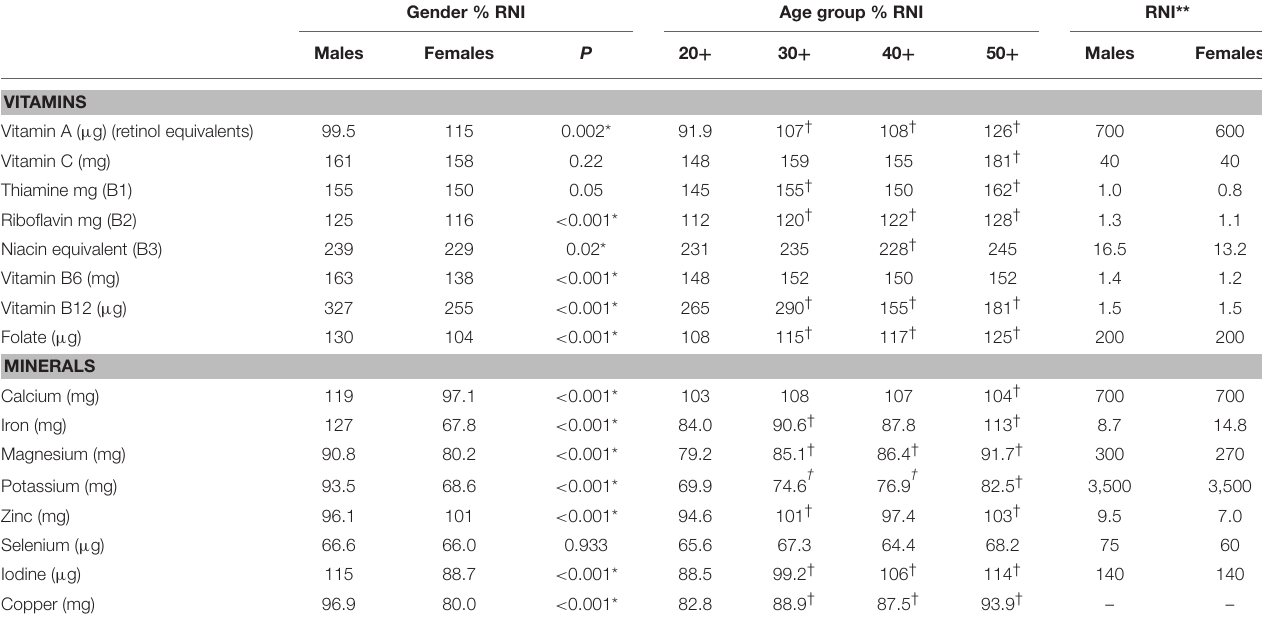
TABLE 2 | Percentage RNI for vitamin and mineral intakes by gender and